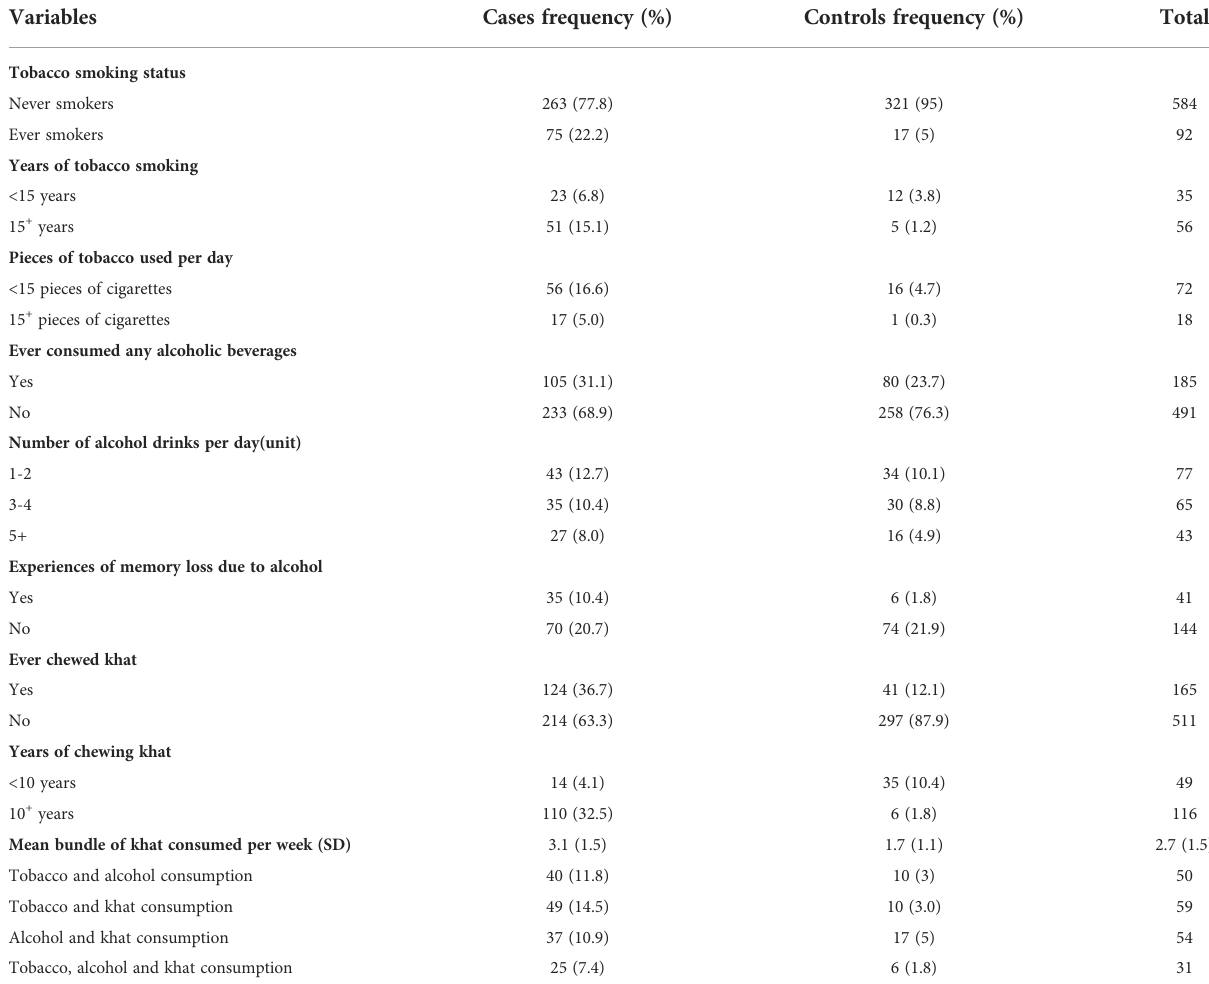
TABLE 2 Behavioral characteristics of cases and controls, Addis Ababa, Ethiopia, February 2019-August